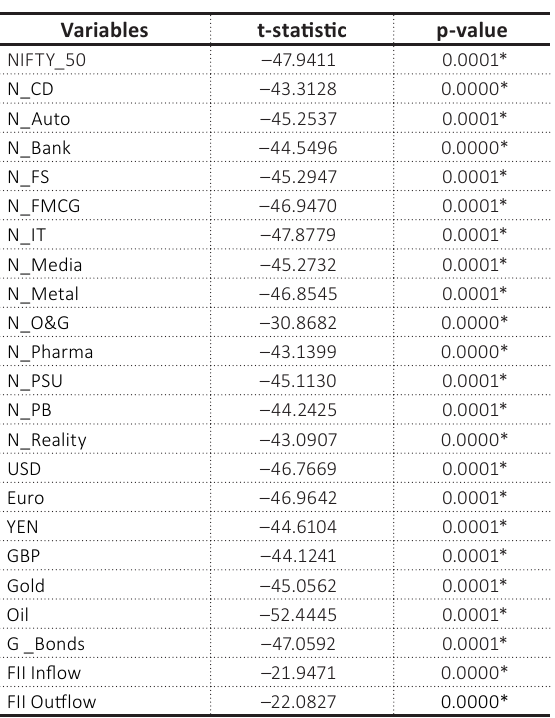
Table 2. Augmented Dickey-Fuller test results